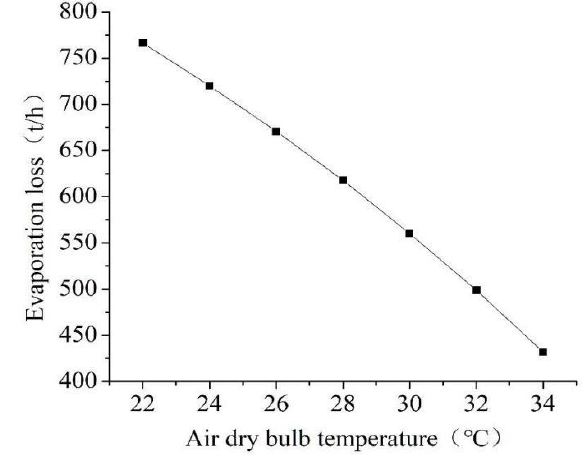
Figure 13. Evaporation loss at vary air dry bulb temperature.